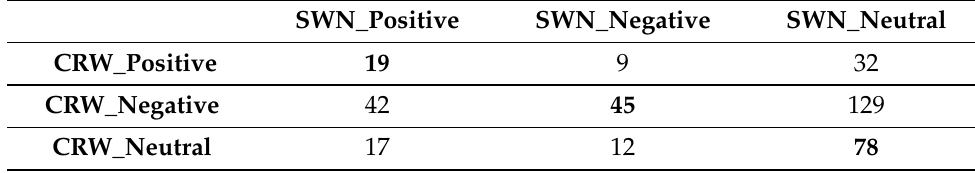
Table 3. Confusion matrix: SentiWordNet (SWN) vs. Crowdflower